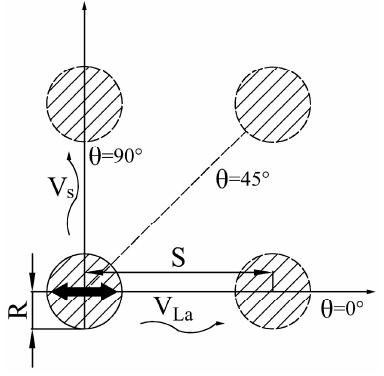
Figure 4. Pile–pile interaction.